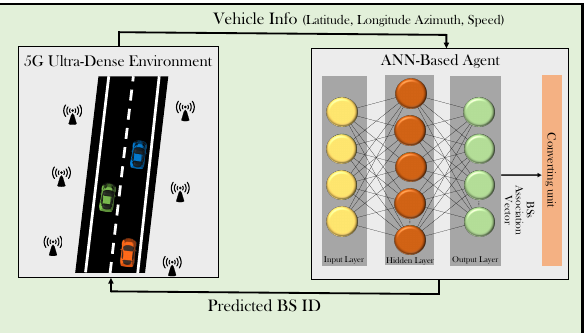
Figure 2. The framework of the proposed ANN-CS